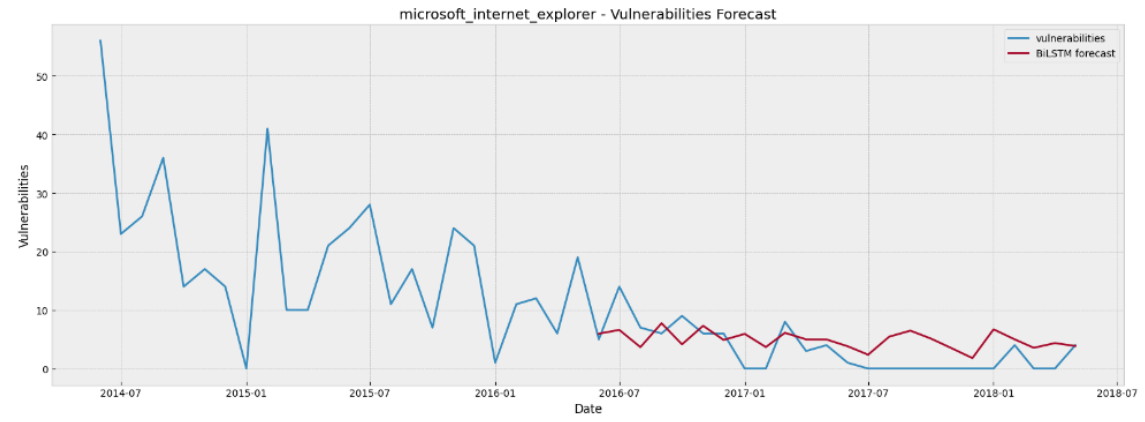
Figure 5. Internet Explorer vulnerability forecasting for 24 steps ahead using BiLSTM.